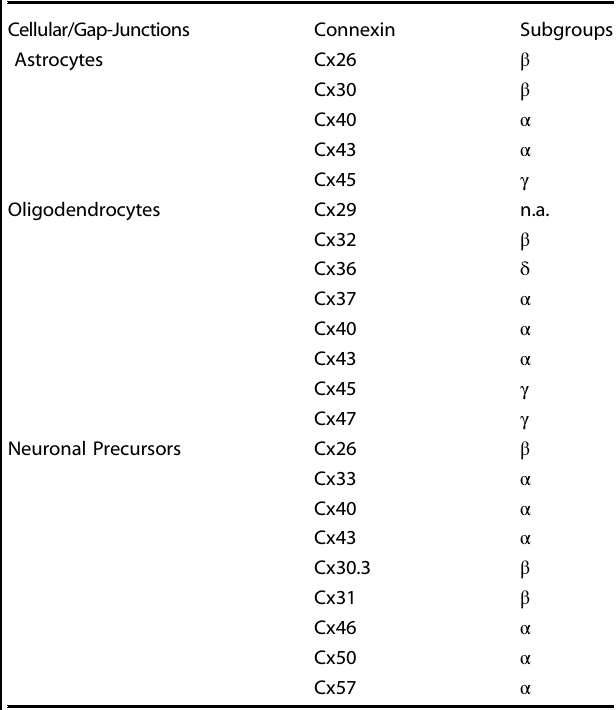
Table 1. Types of various connexins expressed in distinct subgroups of gap-junctions ( 212,213